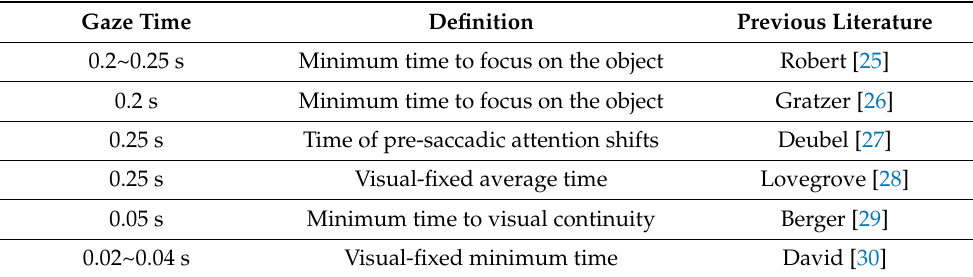
Table 1. Previous literature on gaze time.